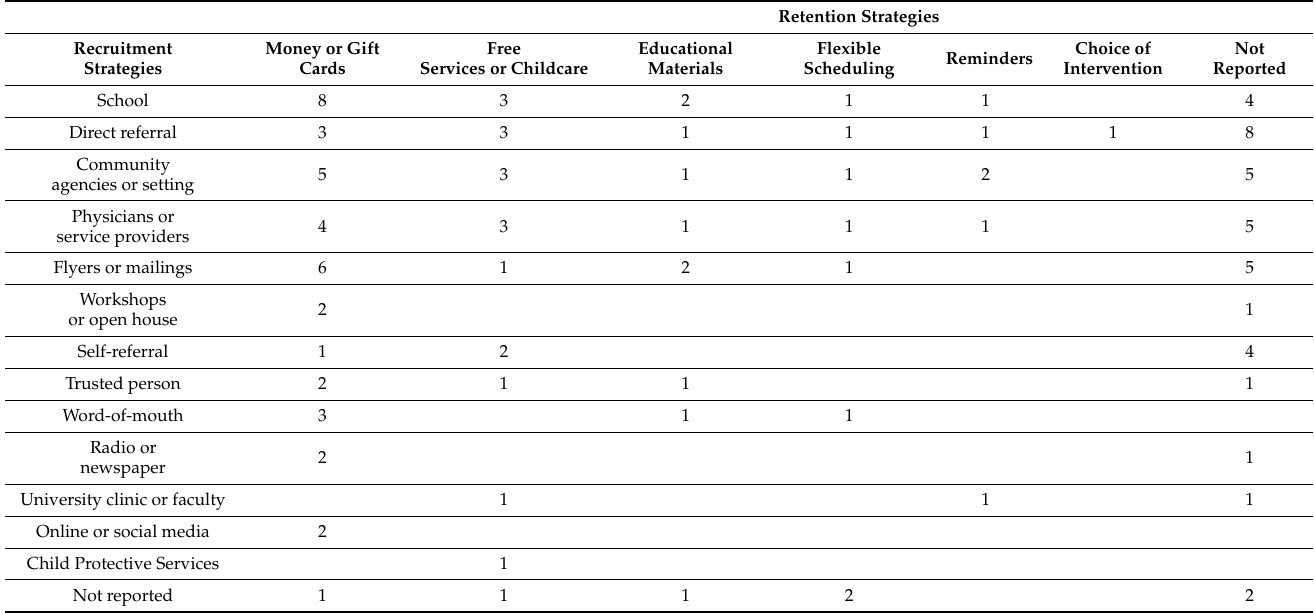
Table 2. Number of Studies Reporting Specific Recruitment and Retention